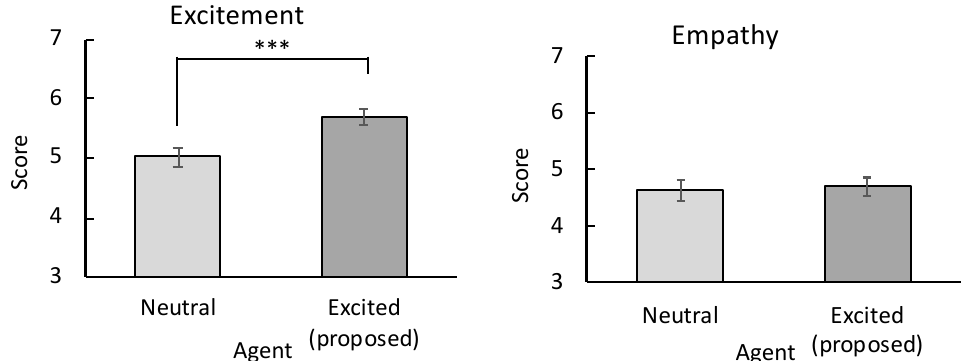
Figure 11. Mean (with standard error) subjective ratings of excitement (left image) and empathy (right image) for agents. *** p <